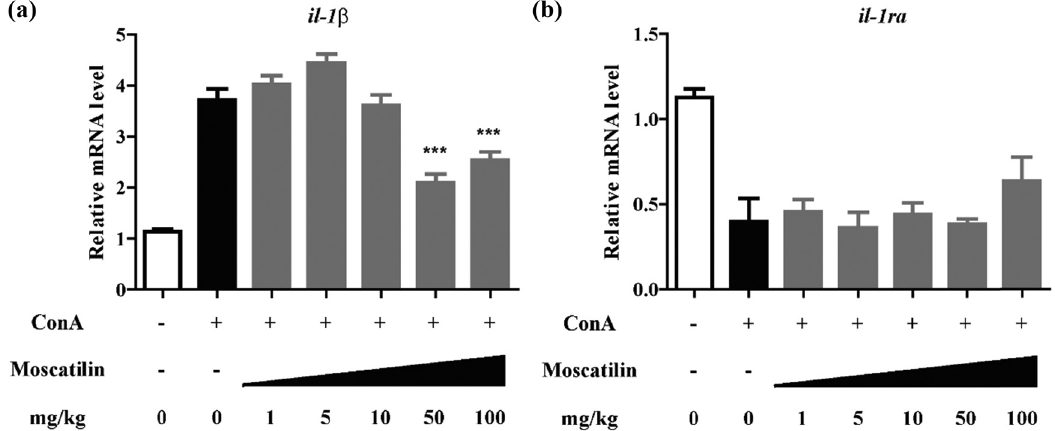
Figure A2: E ff ects of moscatilin treatment on the hepatic production of IL - 1 β and IL - 1Ra. The mRNA expression of il - 1 β ( a ) and il - 1ra ( b ) genes in the liver tissues was detected 24 h after the ConA injection by real - time RT - PCR. Each group contained 5 tissue samples and *** indicated p value less than 0.001 compared to the ConA